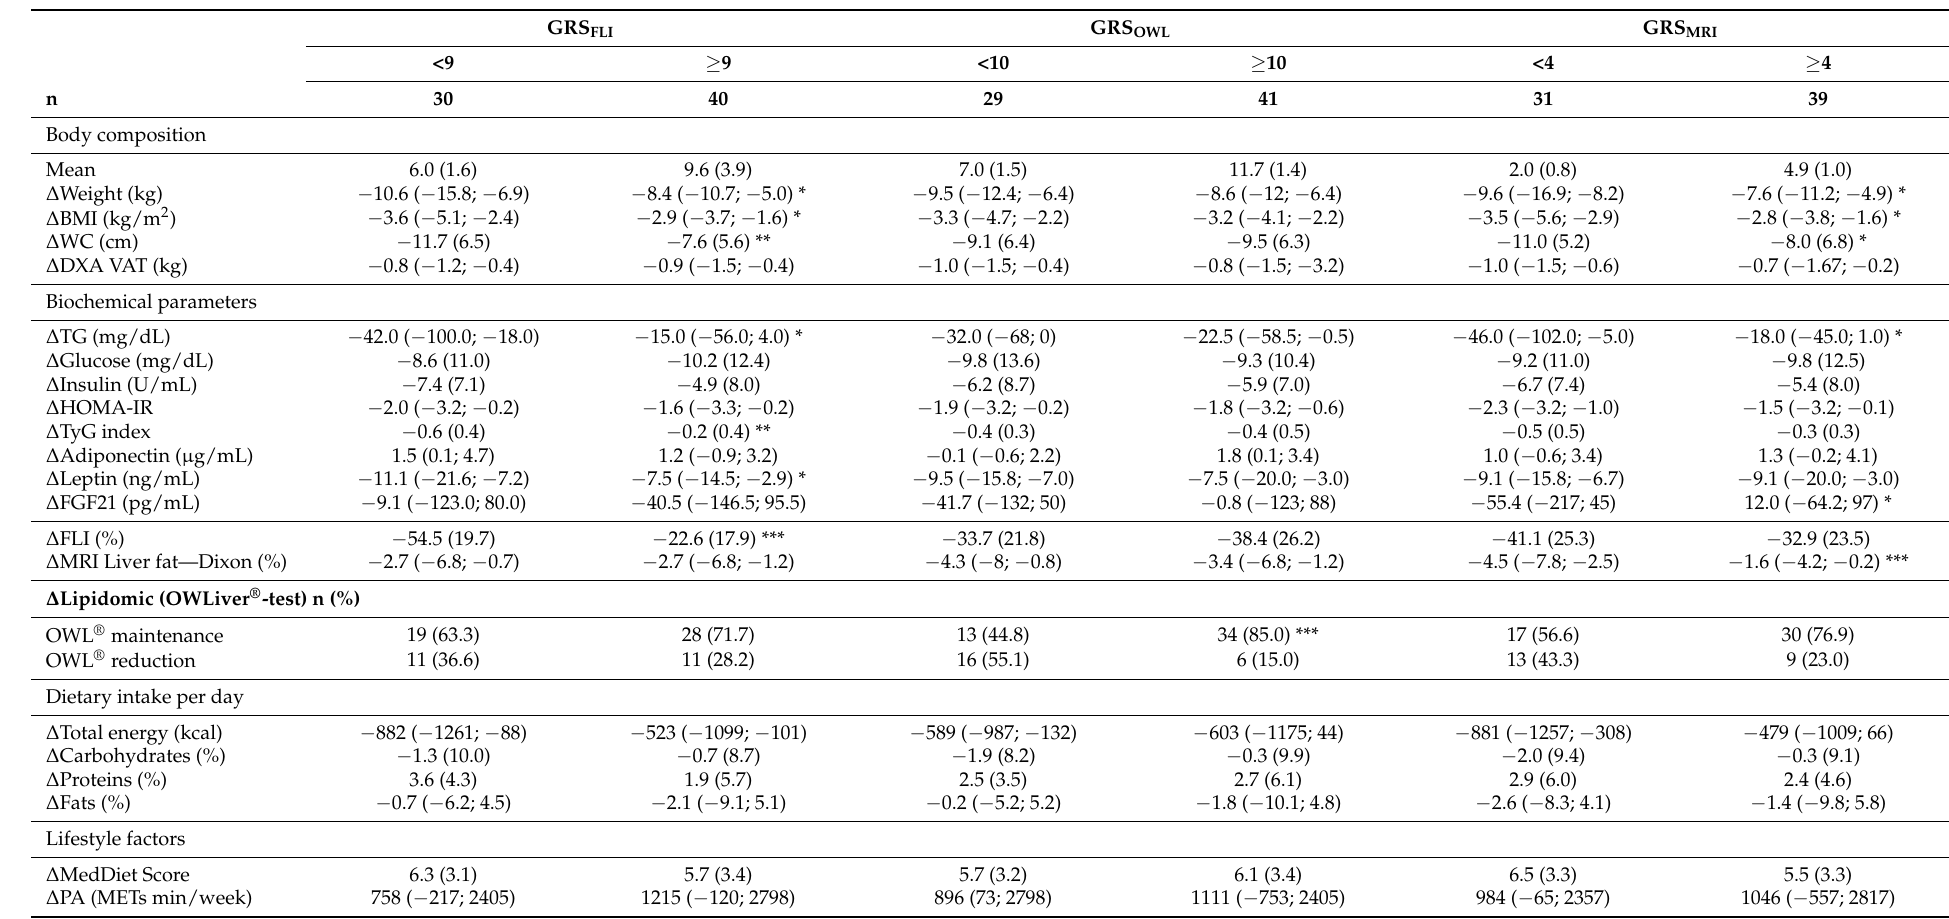
Table 2. Change in body composition, biochemical, dietary and lifestyle factors according to different genetic risk